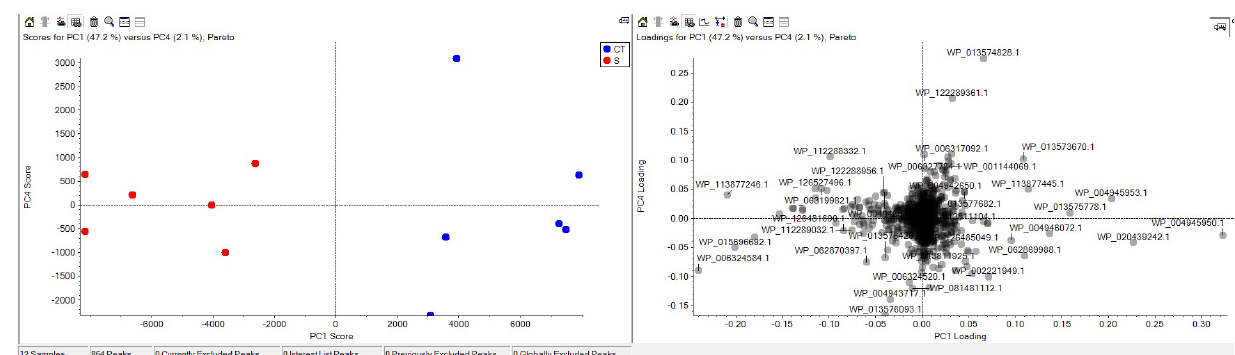
Figure 5. Principal Component Analysis (PCA) of the protein expression in ( A ) Rahnella aquatilis Ra4; ( B ) Serratia plymuthica Sp2, and ( C ) both bacterial strains grown in TSB medium added with 4.4% NaCl at 24 h of incubation (28 °C in shaking).